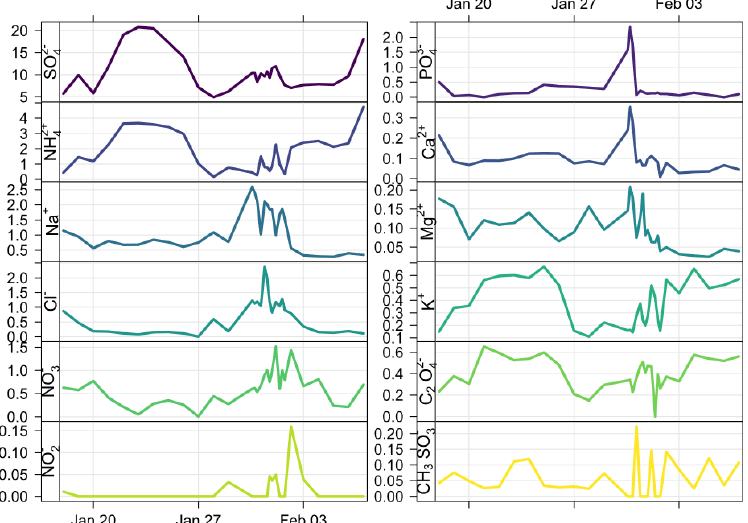
Figure 3. Time series of water-soluble ions (µgm − 3 ) measured during the Bachok demonstration campaign (18 January to 7 February